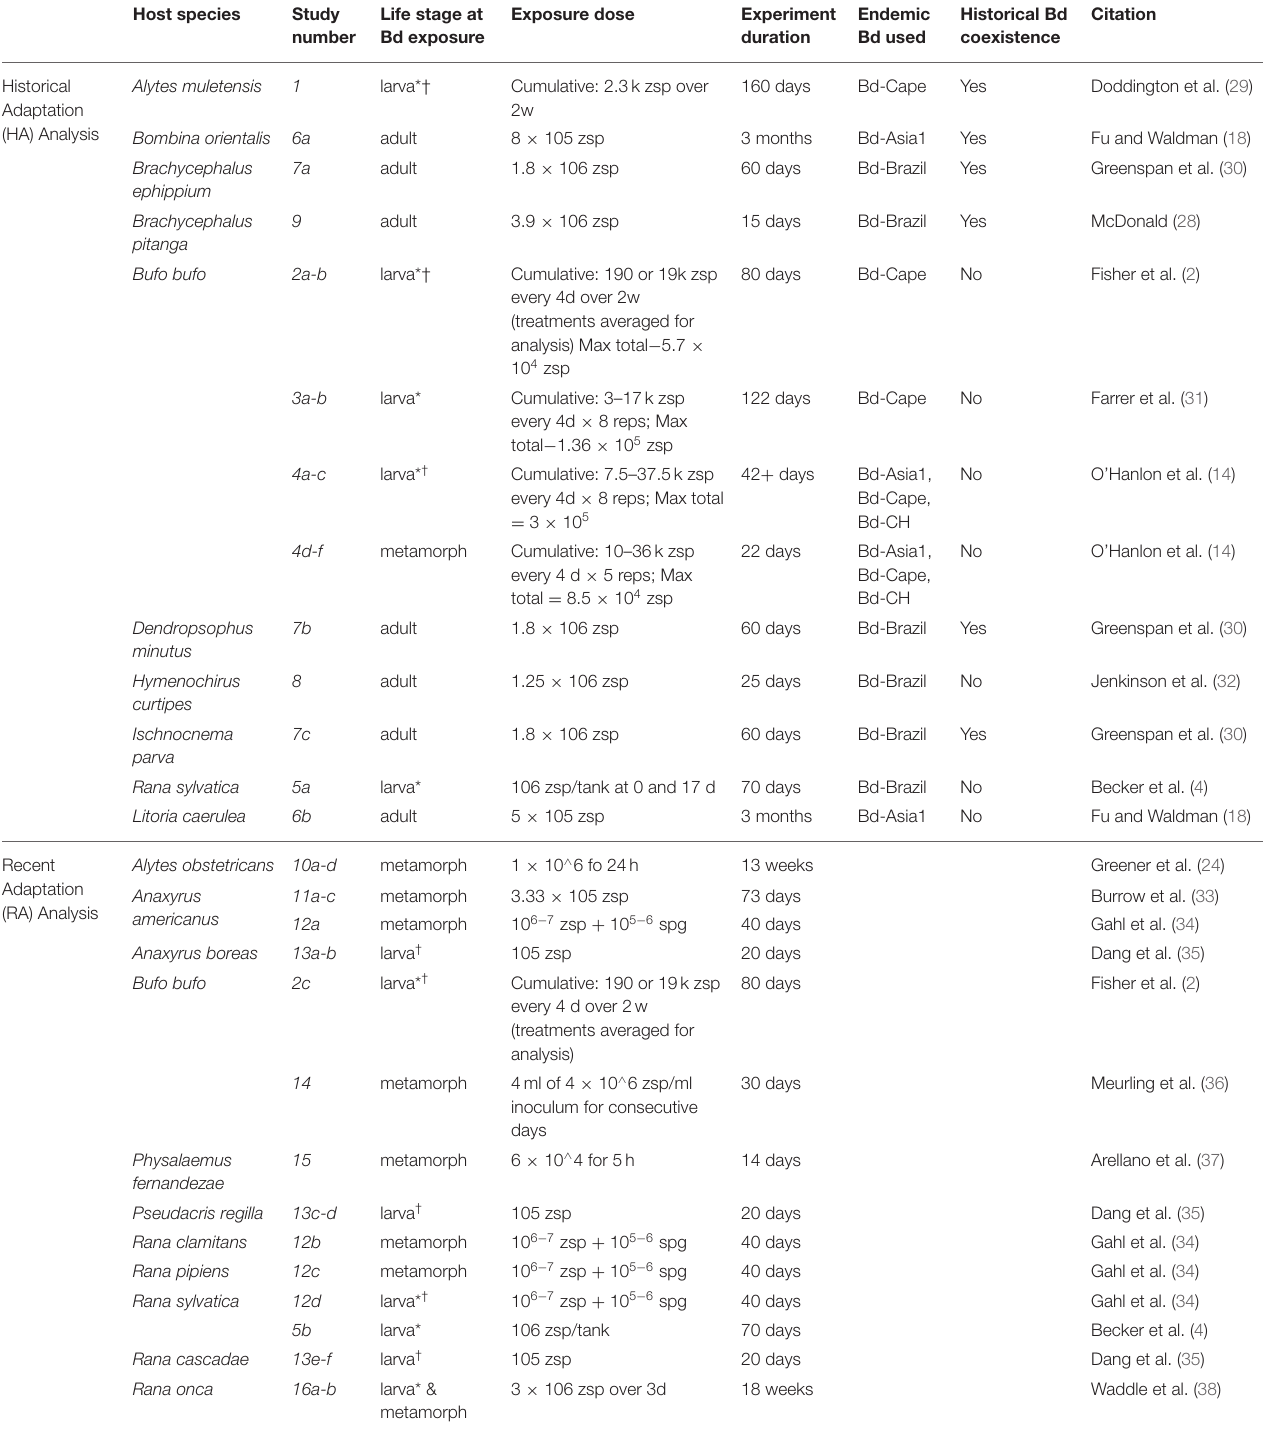
TABLE 1 | Study units included in the two